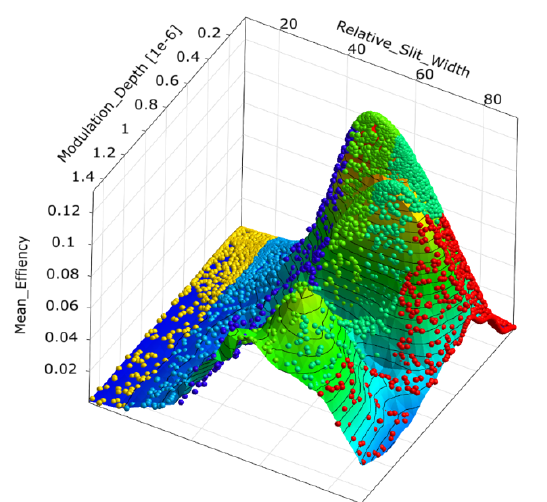
Fig. 1. Metamodel of Optimal Prognosis that shows the influence of the two input parameters Modulation Depth and Relative Slit Width on the Mean coupling Efficiency of the binary grating